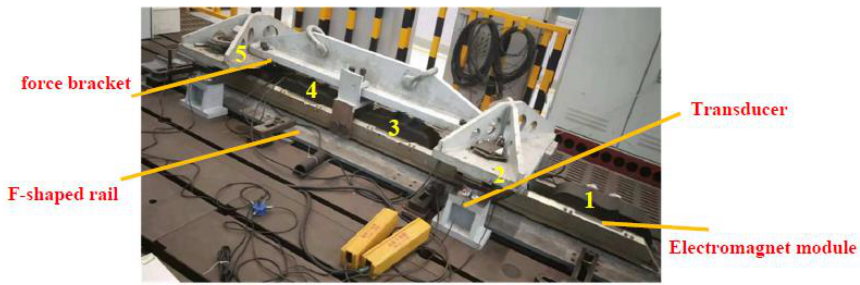
Figure 10. The coil-compensated front-end electromagnet module and corresponding test platform.